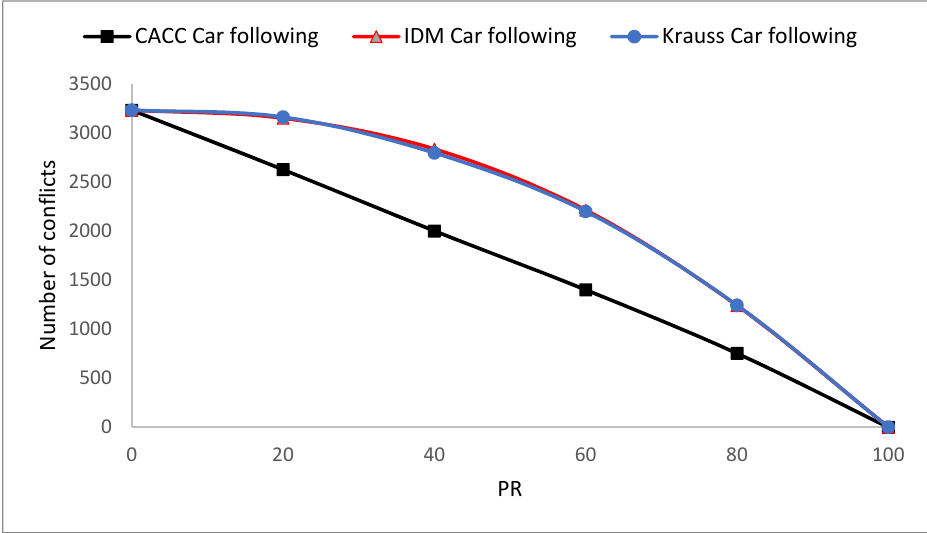
Figure 5. Change in the number of conflicts based on three car-following models.